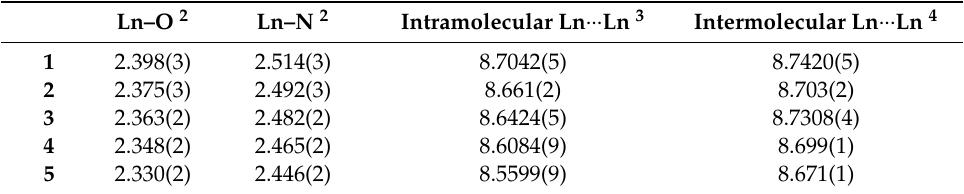
Table 1. Selected bond distances 1 (Å) for 1 – 5 .